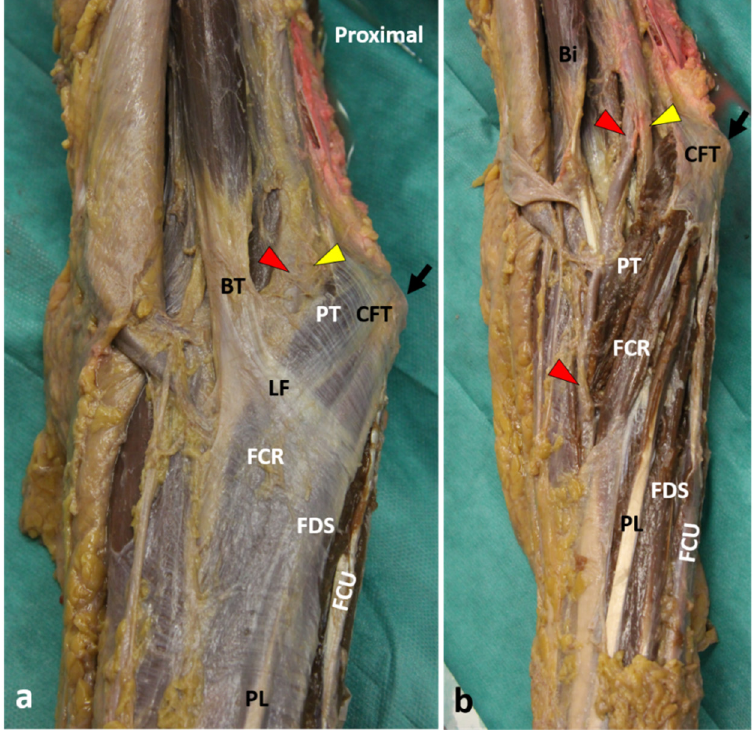
Figure 5. Common origin of flexors from the medial epicondyle. ( a ) Common flexor tendon originating from the medial epicondyle. Muscles are covered by antebrachial fascia. ( b ) The same specimen without fascial covering; the lacertus fibrosus was removed. Black arrow: medial epicondyle, yellow arrowhead: median nerve, red arrowhead: brachial artery, black arrowhead: distal biceps tendon, CFT: common flexor tendon, FCR: flexor carpi radialis muscle, FDS: flexor digitorum superficialis, FCU: flexor carpi ulnaris muscle, LF: lacertus fibrosus (aponeurosis of the biceps brachii), PL: palmaris longus muscle, and PT: pronator teres